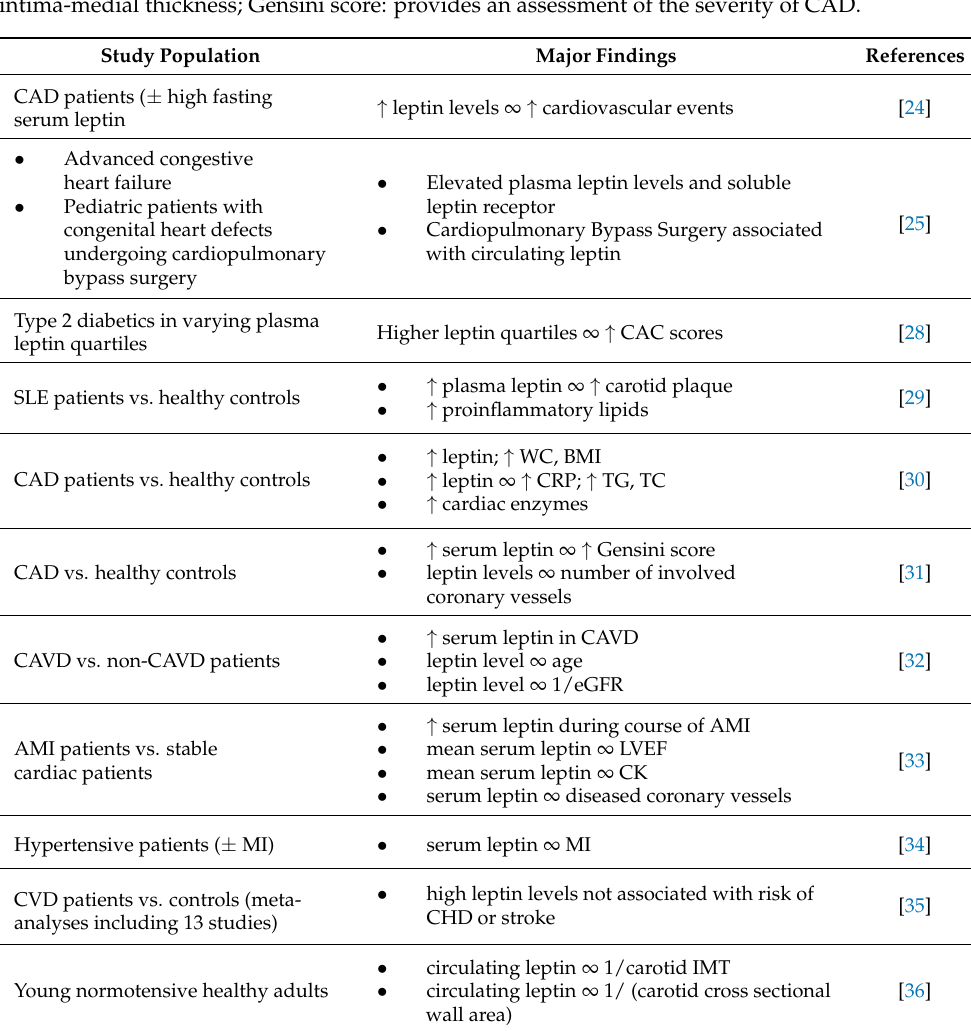
Table 1. Overview of clinical studies defining the role of leptin in vascular dysfunction.